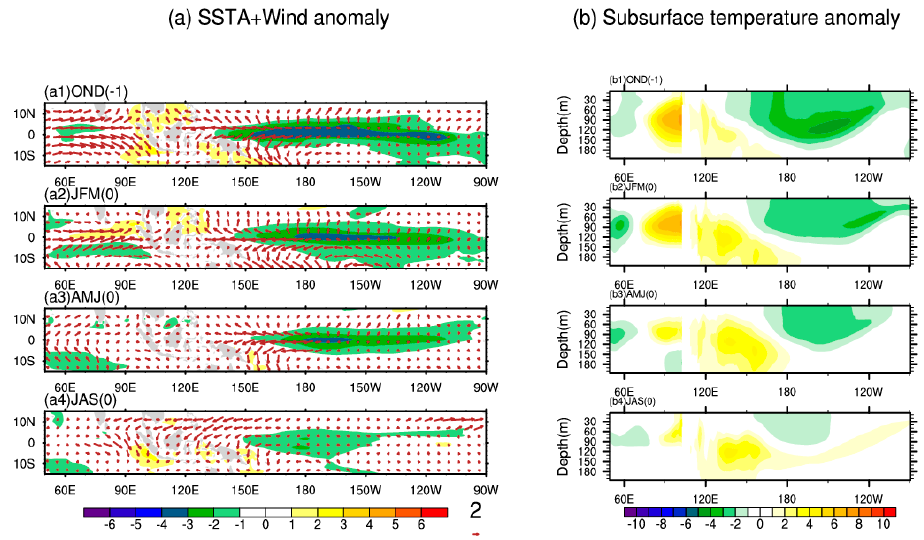
Figure 5. Same as Figure 4, but caused by the type-2 initial errors.